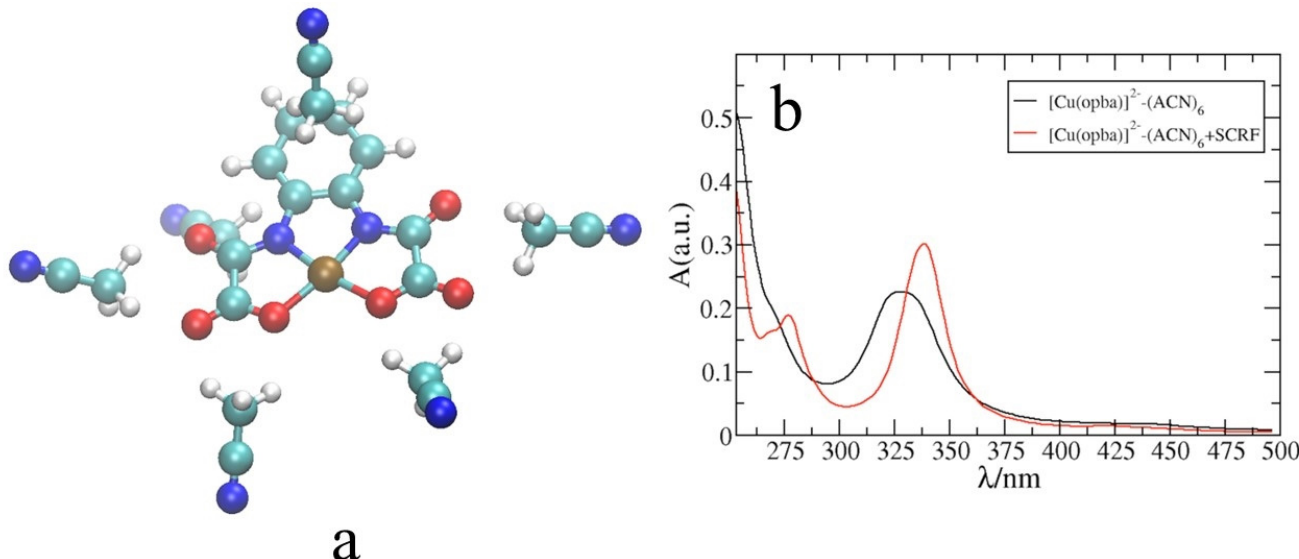
Figure 6. ( a ) [Cu(opba)] 2 − (ACN) 6 B3LYP/SDD optimized structure. Atom colors: copper (brown); carbon (cyan); nitrogen (blue); oxygen (red); hydrogen (white). O . . . H(ACN) hydrogen bond distances (in Å) are in the 2.03–2.05 range. ( b ) Absorption spectra from the micro-cluster (black) and micro-cluster + SCRF (red) approaches.